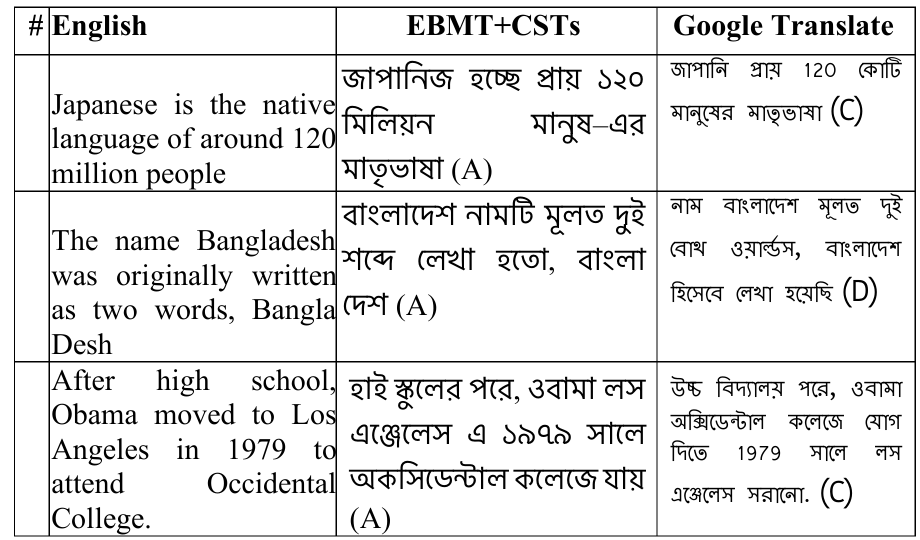
Table 10. Comparison of CSTs output with Google Translate using same testset